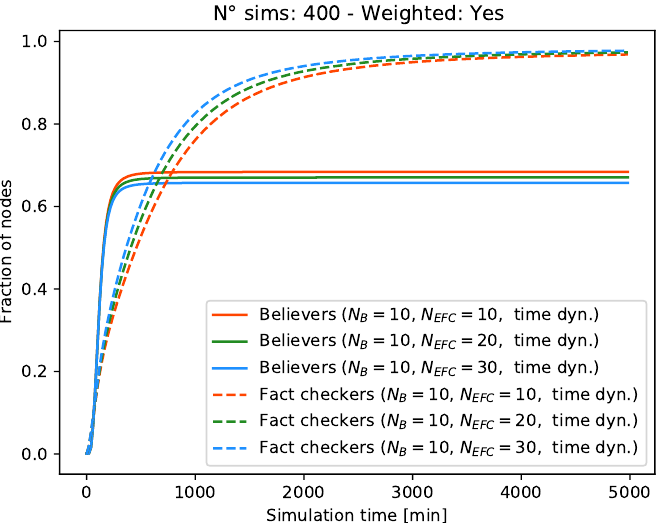
Figure 7. All-time maximum number of Believers and Fact-checkers over time in a weighted network. Figure 7 also confirms that eternal fact-checkers increase the recovery rate of believers: a few hundred seconds into the process, the number of fact-checkers increases by about 1.5% for every 10 eternal fact-checkers added to the network, before saturating towards the end of the simulation, where all nodes (or almost all) have